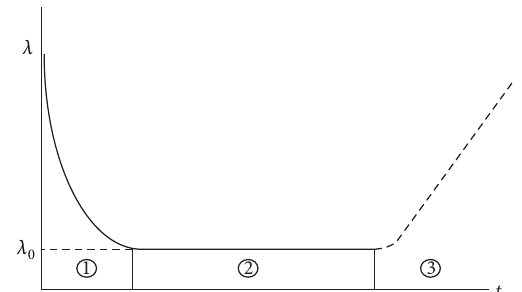
Figure 1: Bathtub curve of failure rate dependence [1]. A area of frequent failures, B area where the level of failure rate is practically constant, and C area where the failure rate increases due to wear of